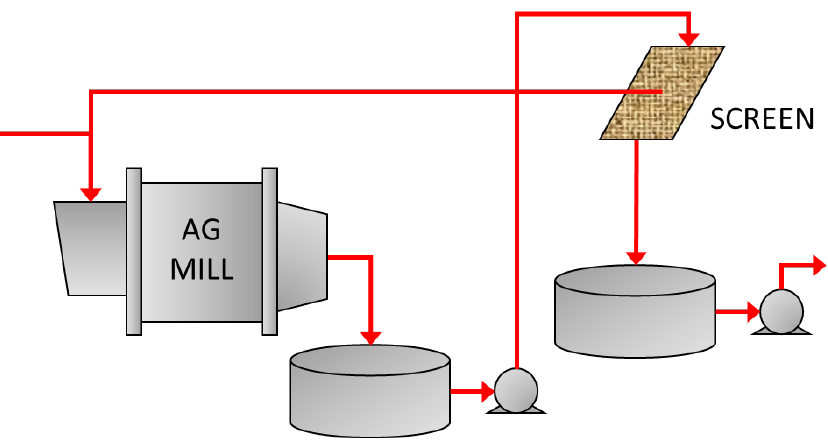
Figure 22. Fully autogenous grinding circuit flow diagram.